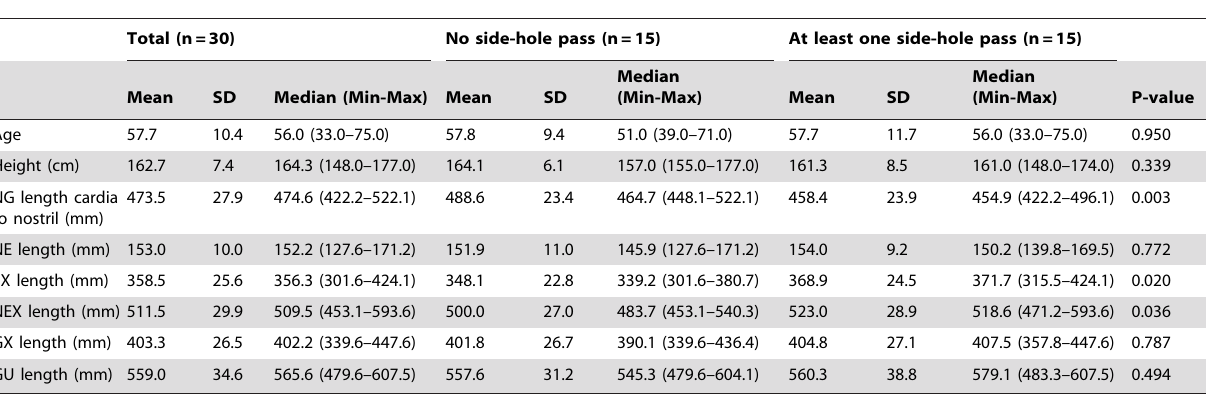
Table 1. Descriptive statistics and comparison between the ‘‘No side-hole pass’’ and the opposite group.